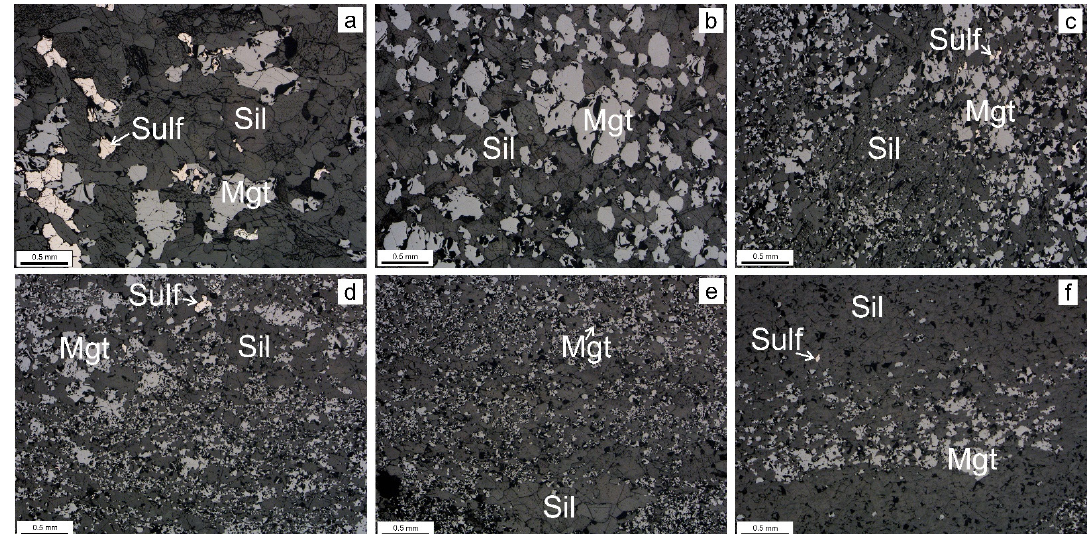
Figure 3. Ore magnetite impregnation in ferruginous quartzites of the Kostomuksha ore field. Mgt—magnetite, Sil—silicates, quartz, Sulf—sulfides. The upper row ( a – c ) presents prevalent ores in the Korpangskoe deposit, the lower row ( d – f )—prevalent ores in the Kostomuksha deposit. Reflected polarized light.